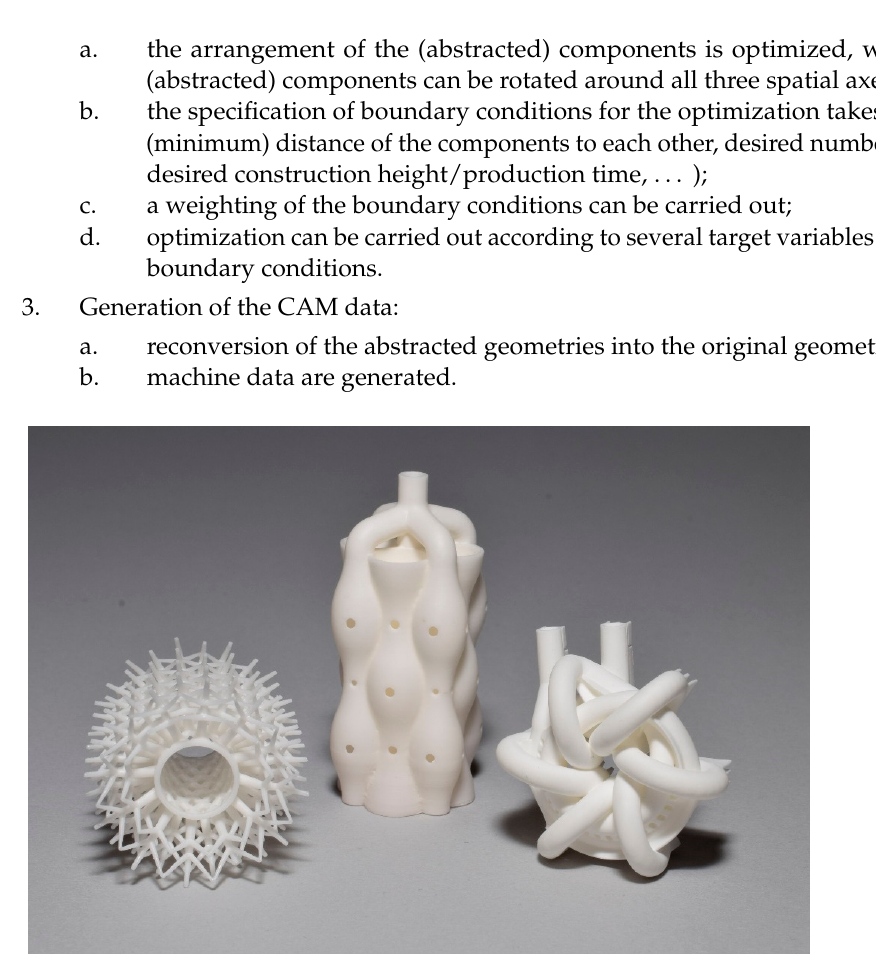
Figure 22. Ceramic heat sinks (left and right) and static mixer (centered) manufactured at Fraunhofer IKTS via CerAM VPP with the CeraFab 7500 device and LithaLox 350 suspension of Lithoz.